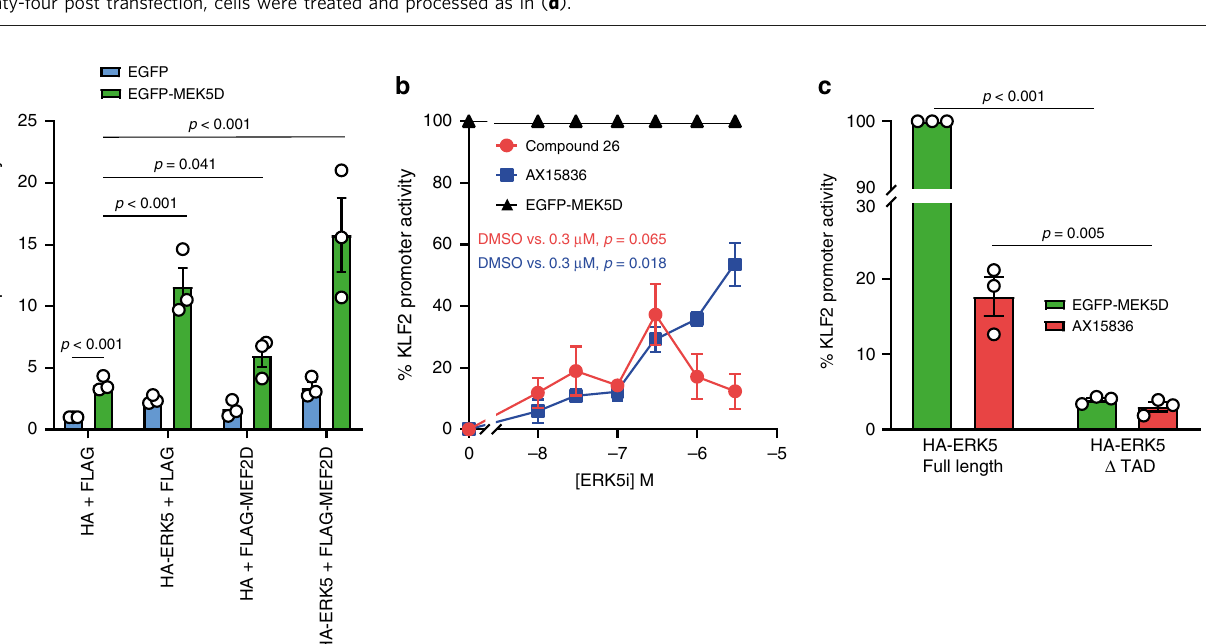
Fig. 6 ERK5i induce expression from the KLF2 promoter and is dependent on ERK5 TAD. a HEK293 cells were transfected with KLF2:LUC and CMV: Renilla together with either FLAG or FLAG-MEF2D and either HA or HA-ERK5 (full length), and either EGFP (control) or EGFP-MEK5D as